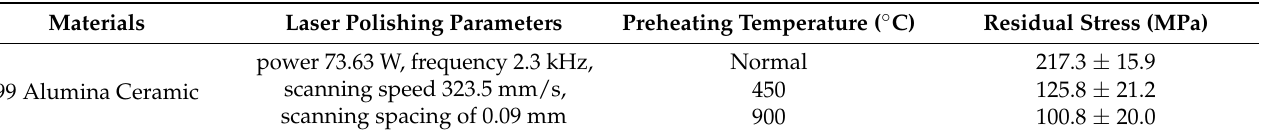
Table 5. Residual stresses on laser-polished alumina surfaces at different preheating